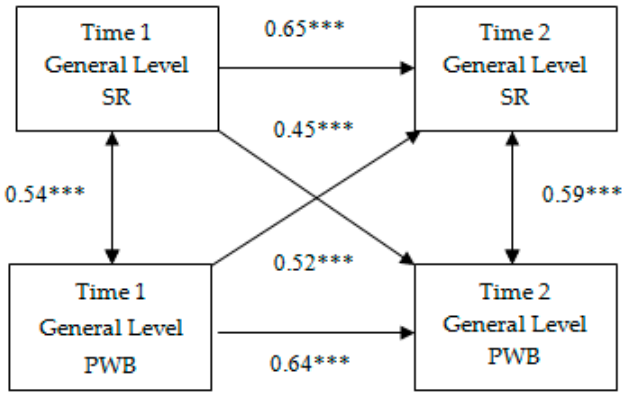
Figure 1. Cross-lagged relationships between self-regulation and psychological well-being. *** = p < 0.001; SR = self-regulation; PWB = psychological well-being.